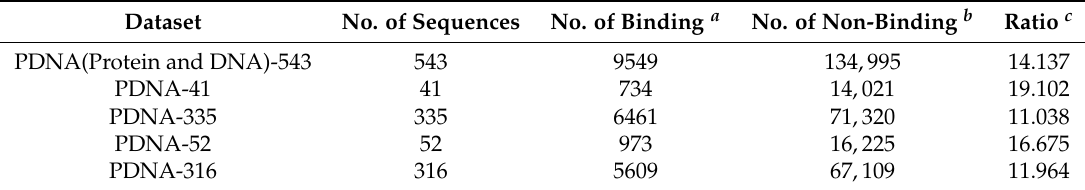
Table 1. Four different datasets of DNA–protein binding